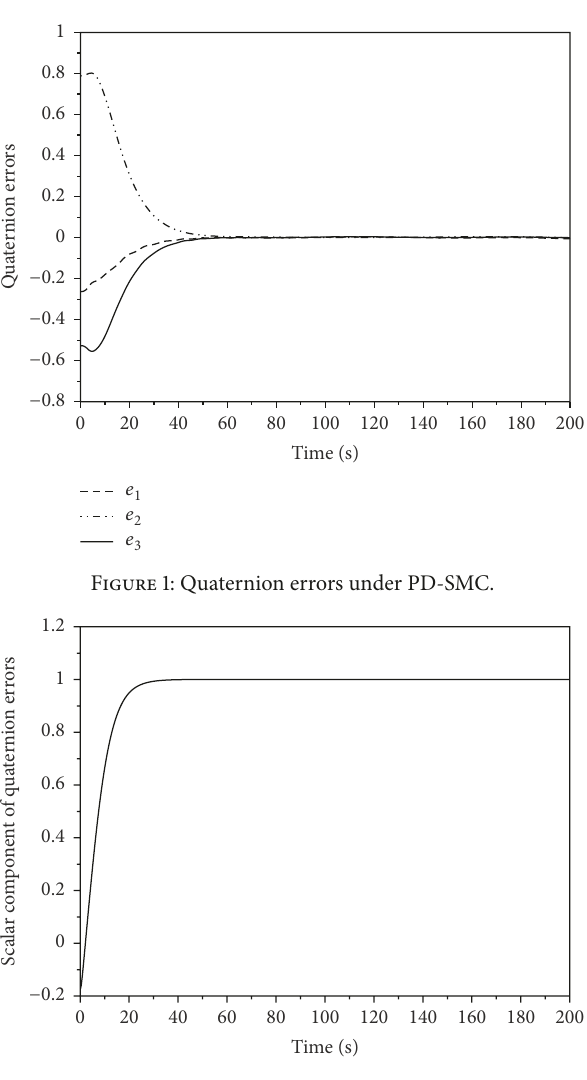
Figure 2: Scalar component of quaternion errors under PD-SMC.